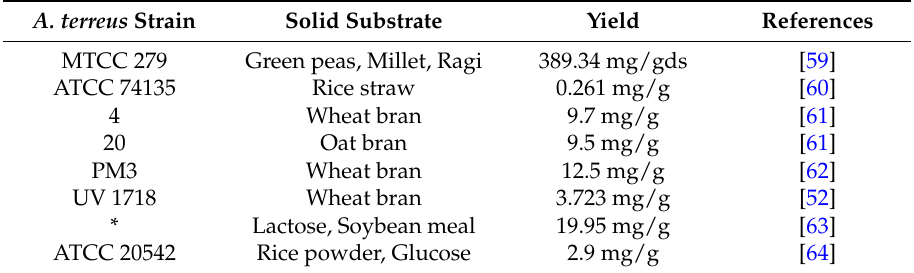
Table 1. Solid state fermentation (SSF) of A. terreus species using raw substrates.